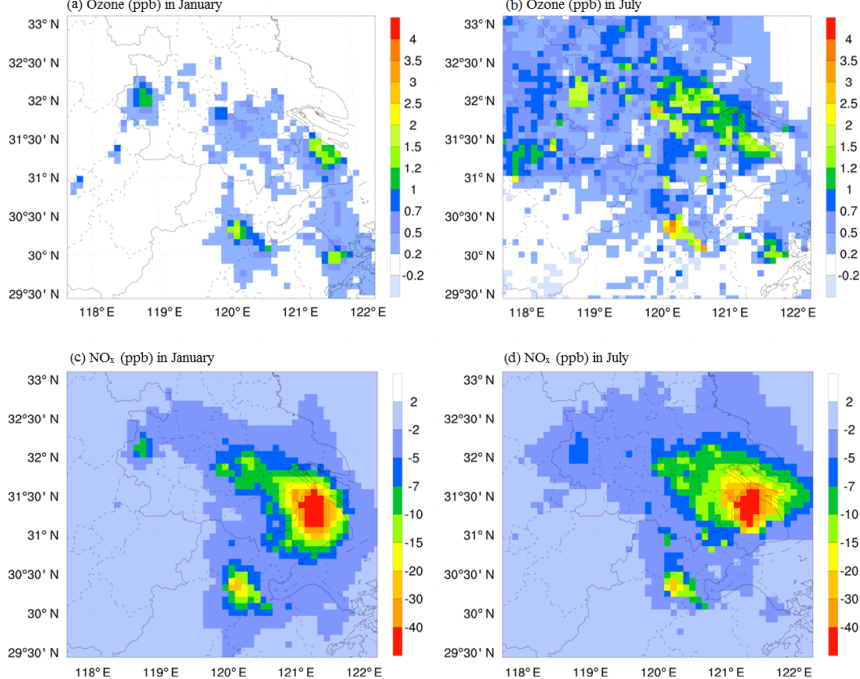
Figure 11. The spatial distributions of monthly averaged differences for O 3 and its precursor NO x between ADDAH and NONAH (ADDAH- NONAH). Differences that are non-significant under the 95% confidence level (Student’s t test) are masked